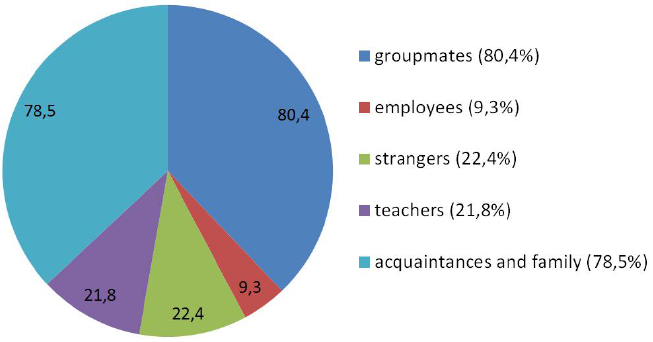
Fig. 2. The user groups with which students communicate on virtual social